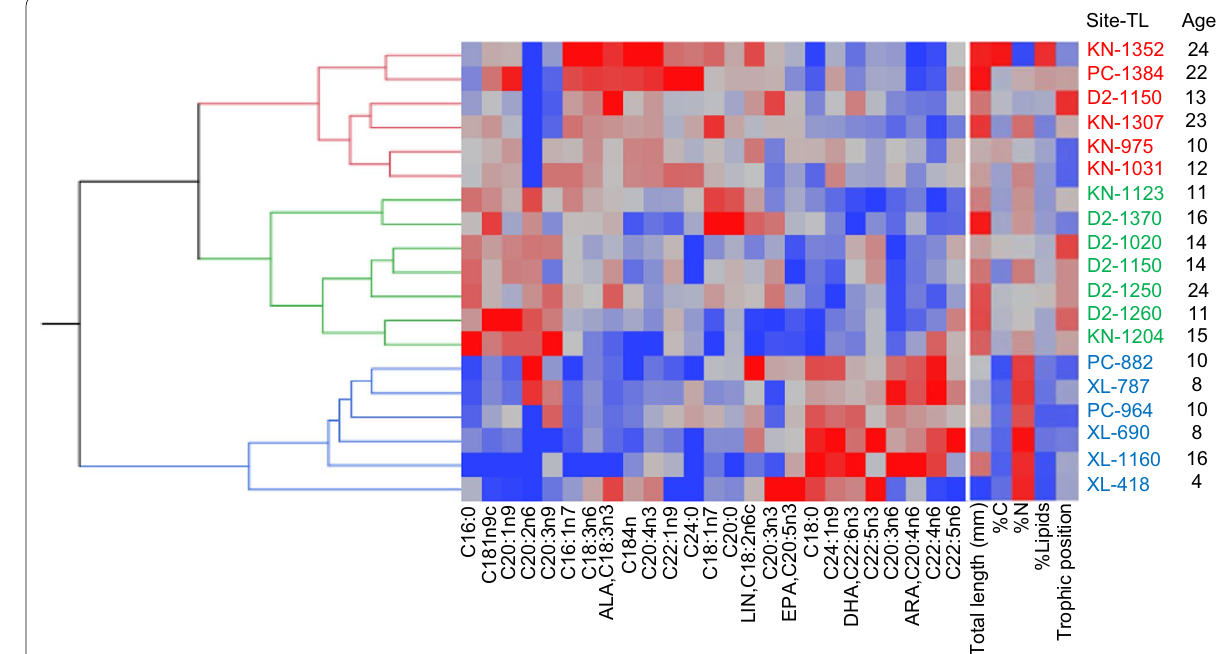
Fig. 6 Cluster analysis showing dendrogram classification and associated heatmap for lake sturgeon based on percent fatty acid (FA mg/g dw/Sum of identified FA mg/g dw*100) in anterior dorsal muscle tissue. Lake sturgeon are identified to the right of the heatmap by capture location and total length (mm), revealing three primary clusters: Kinnickinnic narrows (KN) and near the Xcel Energy Plant (XL) in the St. Croix River, and tailwaters below Lock and Dam 2 (D2) of the Mississippi River. The age ( y ) of the lake sturgeon is provided for reference. Total length (mm), % C, % N, % lipids, and trophic position are indicator variables provided for reference only and were not included in the cluster analysis. Tiles are colored blue and red based on percent fatty acid, which indicates low and high levels,